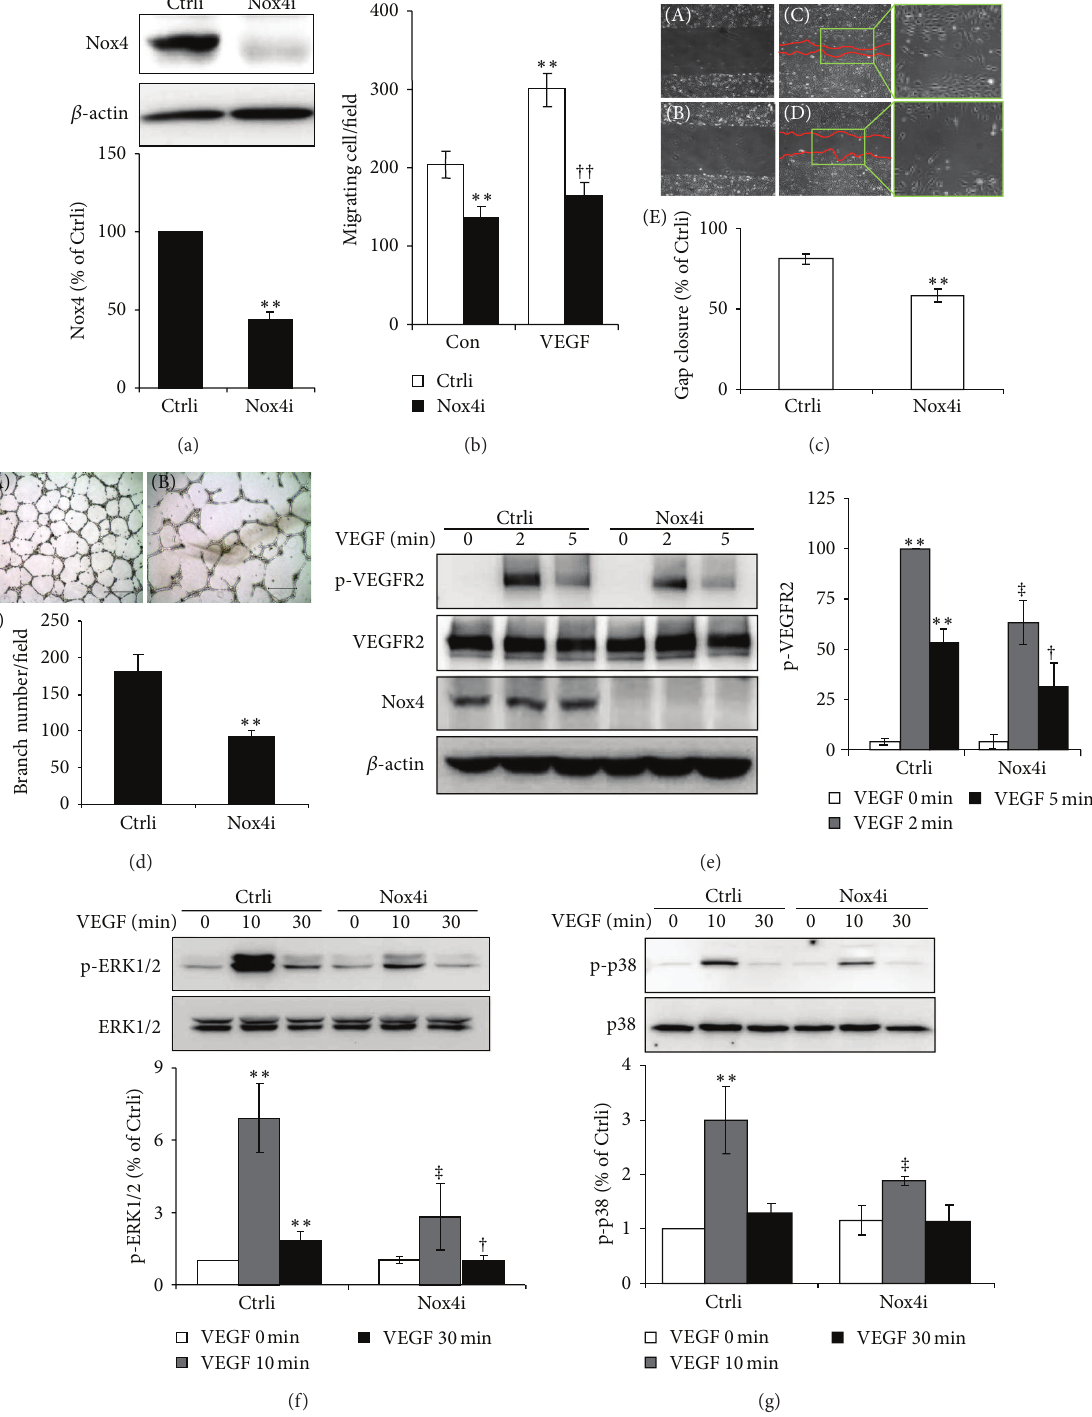
Figure 4: Knockdown of Nox4 in HRECs suppresses endothelial angiogenic response and inhibits VEGFR2 signaling pathway. HRECs were transduced with Ad-Ctrli and Ad-Nox4i for 48h. (a) Nox4 expression in HRECs was determined by Western blot analysis and semiquantified by densitometry. 𝑛 = 3 ; ∗∗ 𝑃 < 0.01 versus Ctrli. (b-c) Migration of HRECs was measured by transwell migration assay (b) and wound healing assay (c). Migrated cell number or gap closure was calculated from 3 different wells. ∗∗ 𝑃 < 0.01 versus Ctrli and ‡ 𝑃 < 0.01 versus Ctrliwith VEGF. Results represent 3 independent experiments. (d) Endothelial tube formation capacity was evaluated by Matrigel assay. HRECs were seeded on Matrigel for 16h and tube numbers were counted from 3 random visual fields. (d-A) HRECs with Ad-Ctrli, (d-B) HRECs with Ad-Nox4i, and (d-C) quantification results. ∗∗ 𝑃 < 0.01 versus Ctrli. Results represent 3 independent experiments. (e–g) Phosphorylation of VEGFR2(e),ERK(f),andP38(g)inducedbyVEGF(50ng/mL)wasdeterminedbyWesternblotanalysisandsemiquantifiedbydensitometry. 𝑛 = 4 ; ∗∗ 𝑃 < 0.01 versus Ctrli and † 𝑃 < 0.05 or ‡ 𝑃 < 0.01 versus Ctrli with